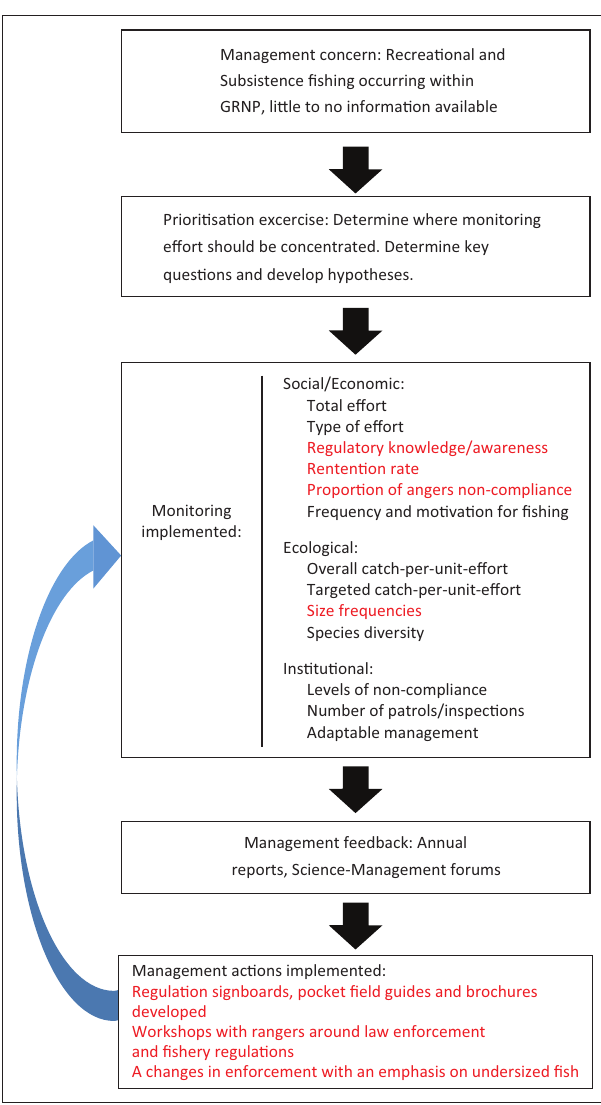
FIGURE 2: Example of how the monitoring framework has been adopted in the Garden Route National Park recreational and subsistence line fisheries. Text in red shows how areas of concern (identified through monitoring key indicators) were addressed in management actions. The impact of these actions is then re-assessed through the monitoring